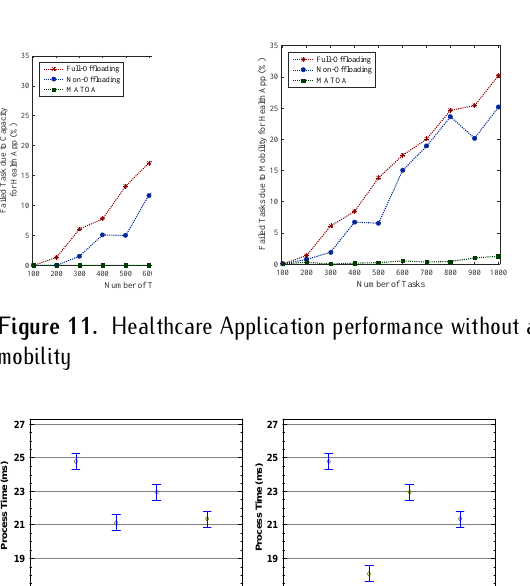
Figure 10. Augmented Application performance without and with mobility